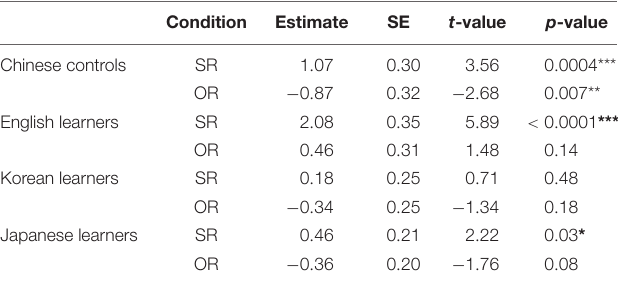
TABLE 4 | Logistic mixed-effects models by participant group and RC type including all perfect utterances. Condition Estimate